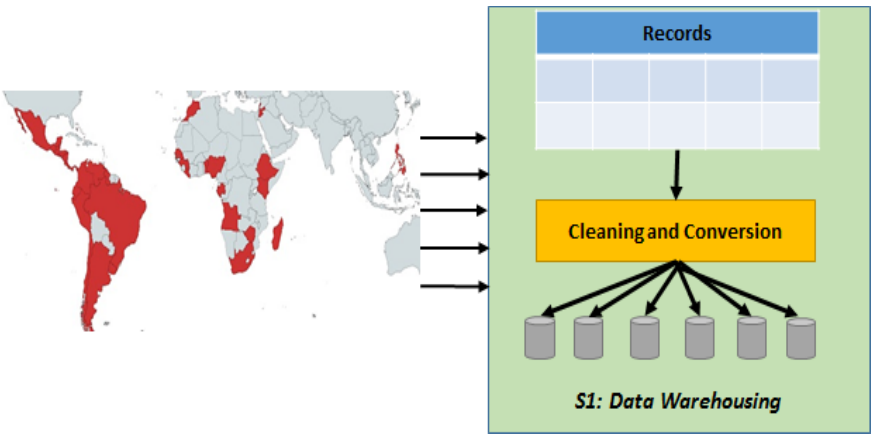
Figure 4. Data warehousing subsystem.